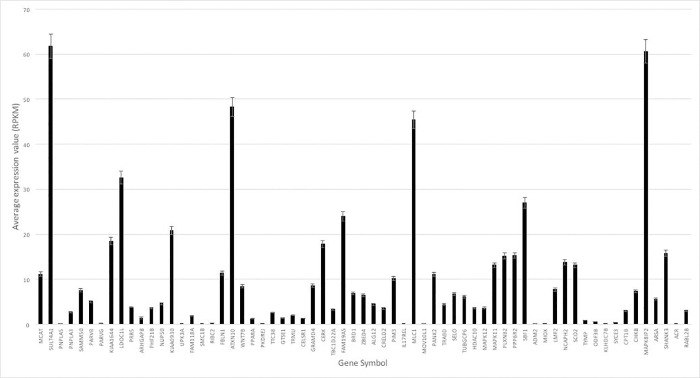
Average expression of 22q13 genes.The average expression value for each of the 65 genes on 22q13 is shown, arranged from most proximal (left) to most distal (right) on chromosome. Error bars represent the standard error of the mean.